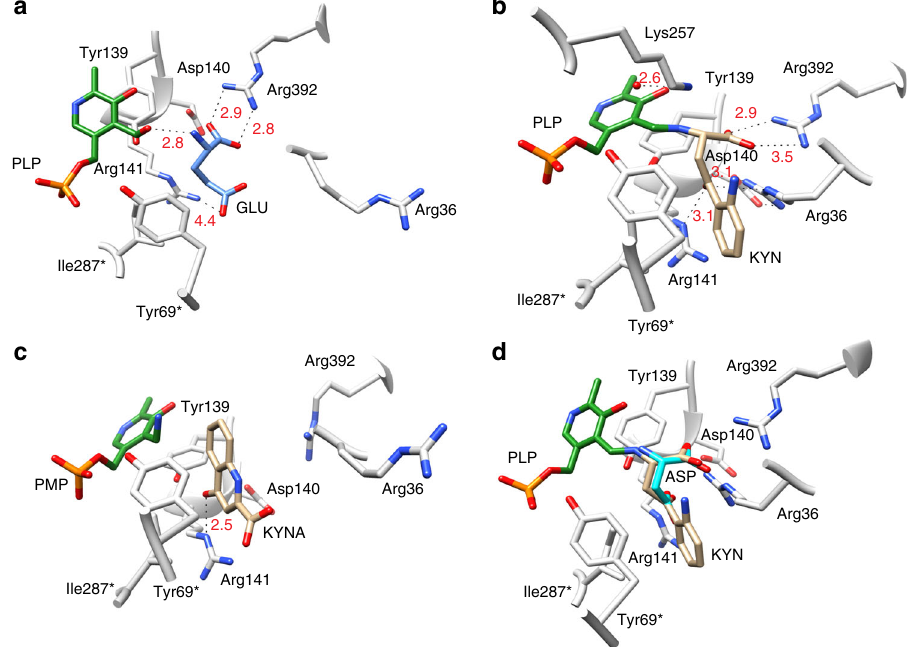
Fig. 4 Rv3722c structure with bound ligands. a Stick representation of Rv3722c in complex with glutamate (GLU; blue). b Rv3722c in complex with kynurenine (KYN; tan). c Rv3722c in complex with kynurenic acid (KYNA; tan). d Kyn mimics Asp in the active site pocket of Rv3722c. Modeling aspartic acid (ASP; cyan) into the electron density of the aliphatic chain of KYN (tan) reveals a structural mimicry that is potentially behind the capability of Rv3722c to use KYN as an amino donor. For all fi gures, active site residues are in light gray, and pyridoxal phosphate (PLP) or pyridoxamine phosphate (PMP) in green. Ligand interactions are shown as dashed lines, and distances are in angstroms. (Asterisk denotes a residue from the second monomer.) See also Supplementary Figs. 6 –